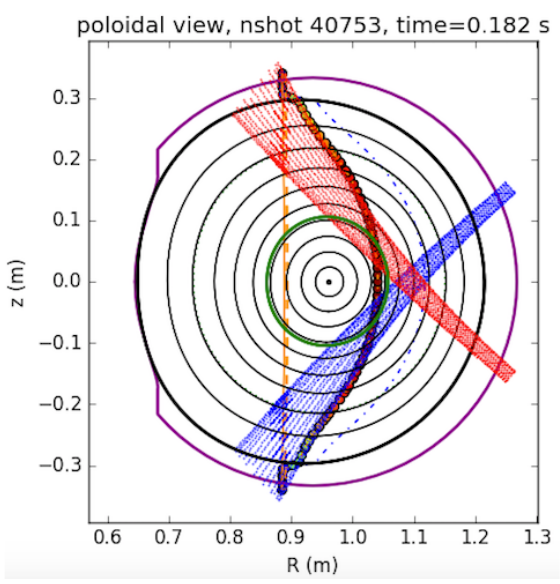
Fig. 9. Plasma equilibrium and main EC resonances for shot #40753 with symmetric launch: the probe beam (in red) and received beam intersect themselves close to the estimated position of the q=2 resonant surface on the equatorial plane, and not far from the UH resonance.